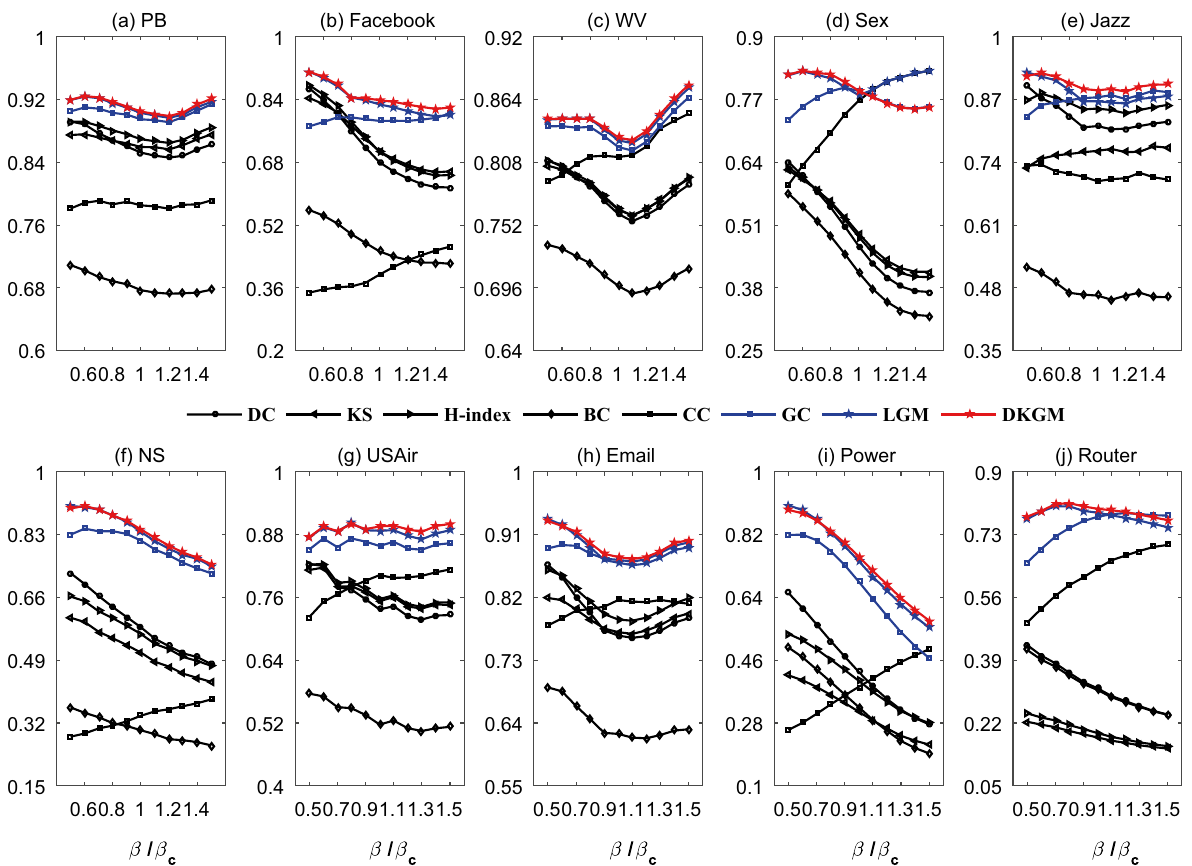
Figure 2. The algorithms’ accuracies measured by Kendall’s Tau for different β . The black symbols represent the five classic algorithms (DC, KS, H-index, BC and CC), the blue symbols represent the typical algorithms based on the gravity law (GC and LGM), and the red symbol represents our